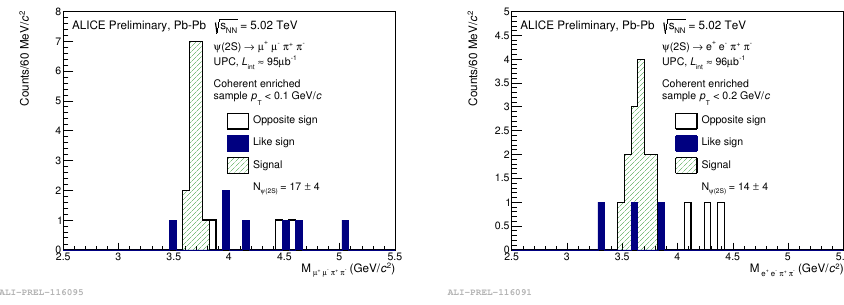
Figure 9. Invariant mass distributions for ψ (2 S ) → µ + µ − π + π − and ψ (2 S ) → e + e − π + π − decays col- √ s NN = 5 . 02 lected by ALICE in Pb–Pb UPC at